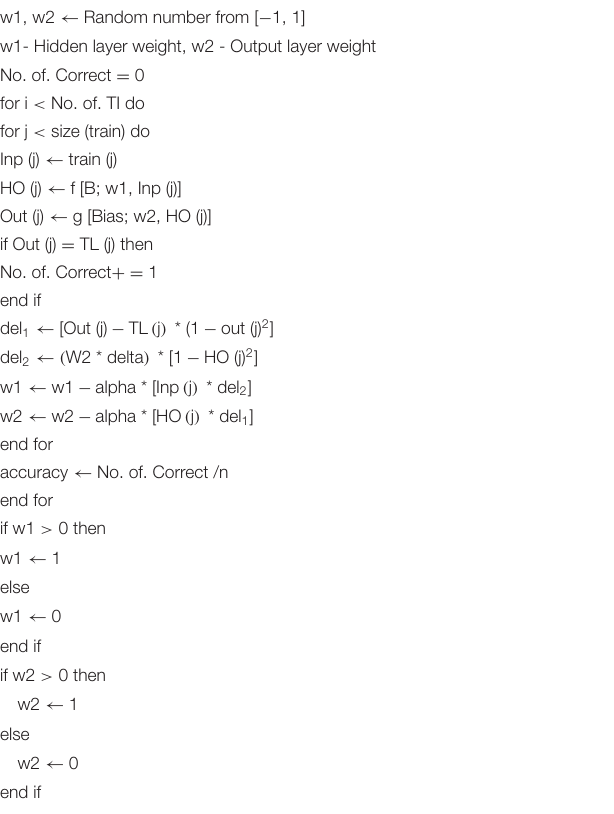
ALGORITHM 1 | Random Sigmoidal Artificial Neural Network